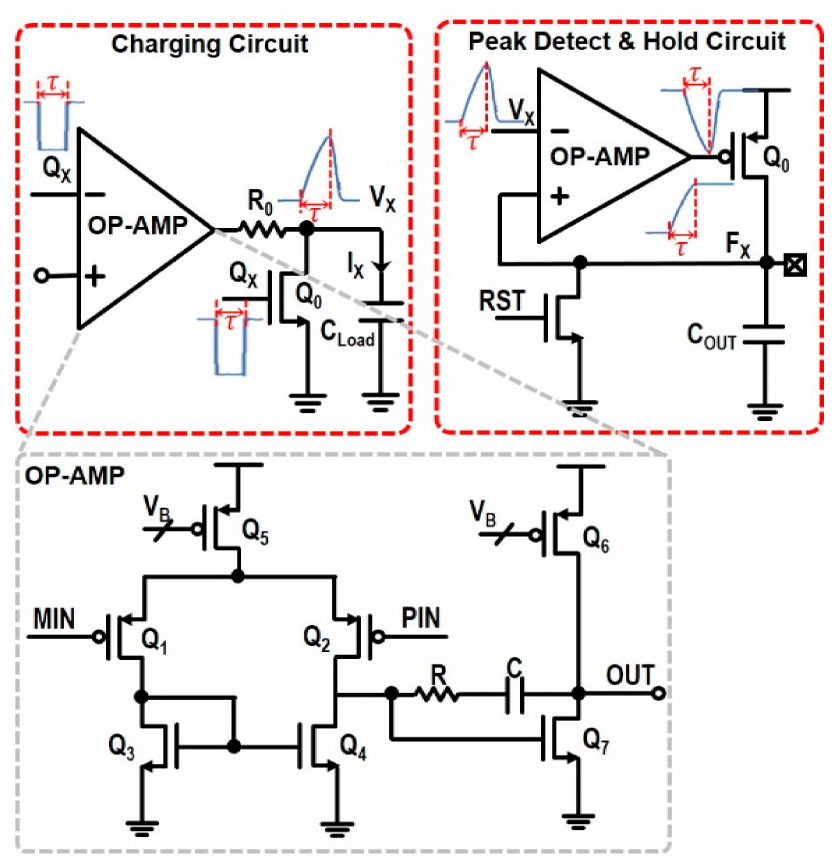
Figure 3. Schematic diagrams of the integrator charging circuit and the PDH